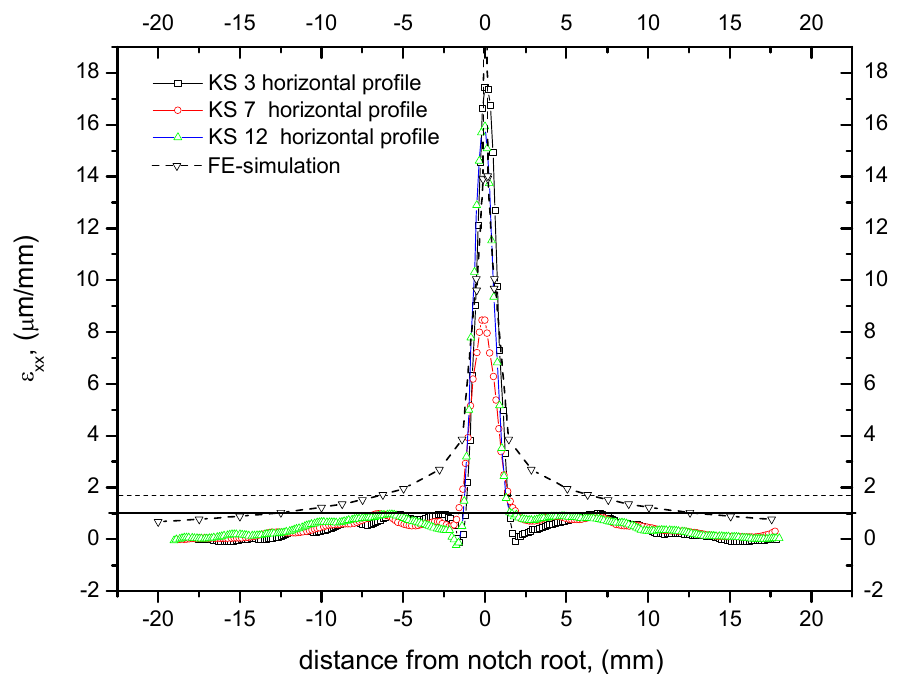
Figure 6. Horizontal profile lines of e experimental and simulated. Dashed line represent xx strain at yielding providing a process zone with of 2.4 mm (acc. to method 1), whereas solid horizontal line touches the first maxima at left and right side of the center peak leading to a process zone width of 6.3 mm (acc. to method